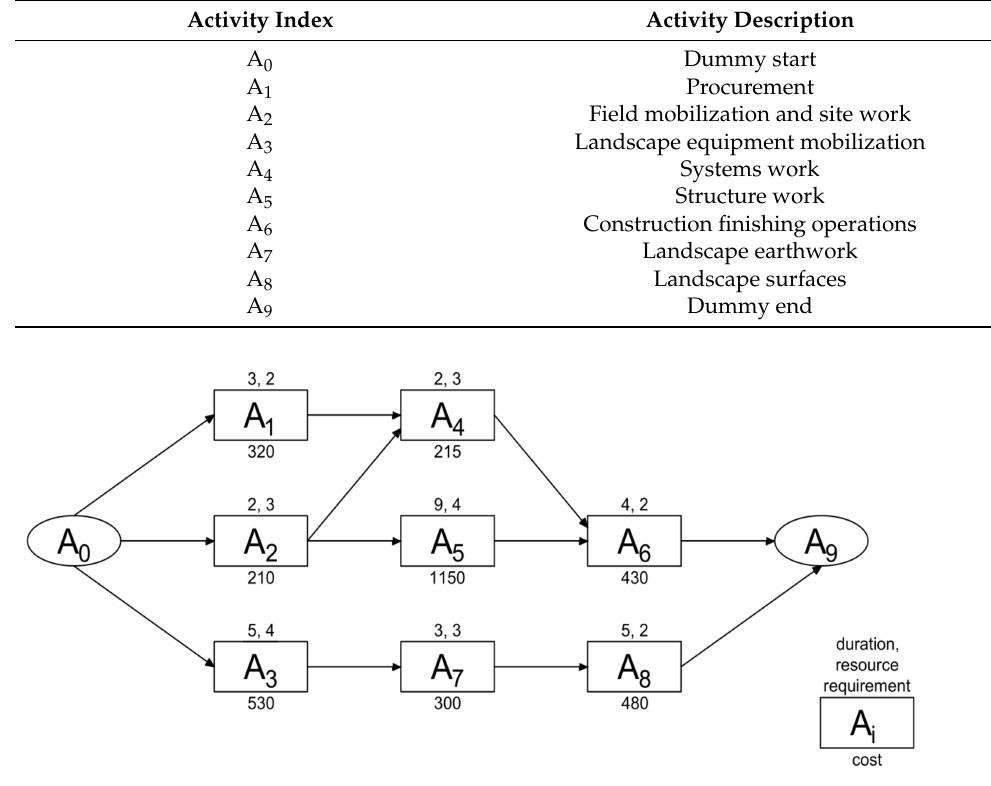
Figure 3. The network of a test problem